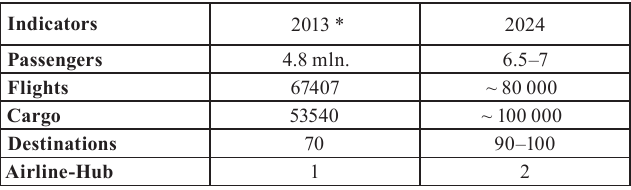
Summary of Experts’ Estimate on RIGA International